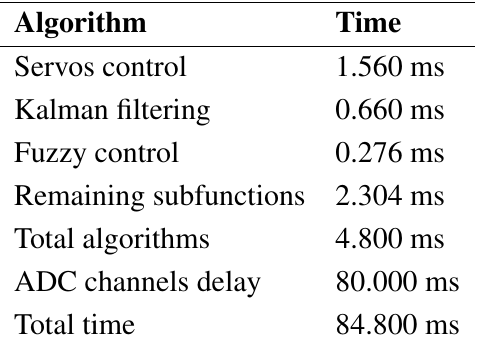
Table 2. Processing time of the principal